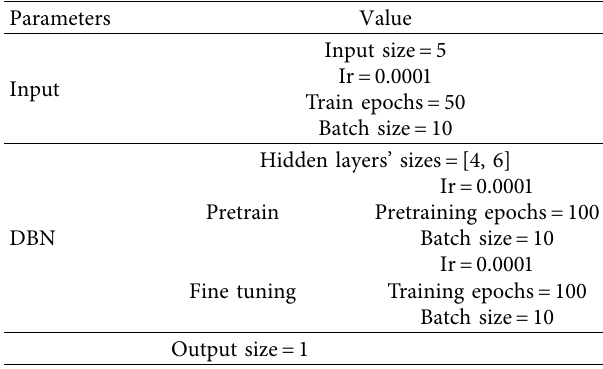
Table 7: The DBN parameter setting.